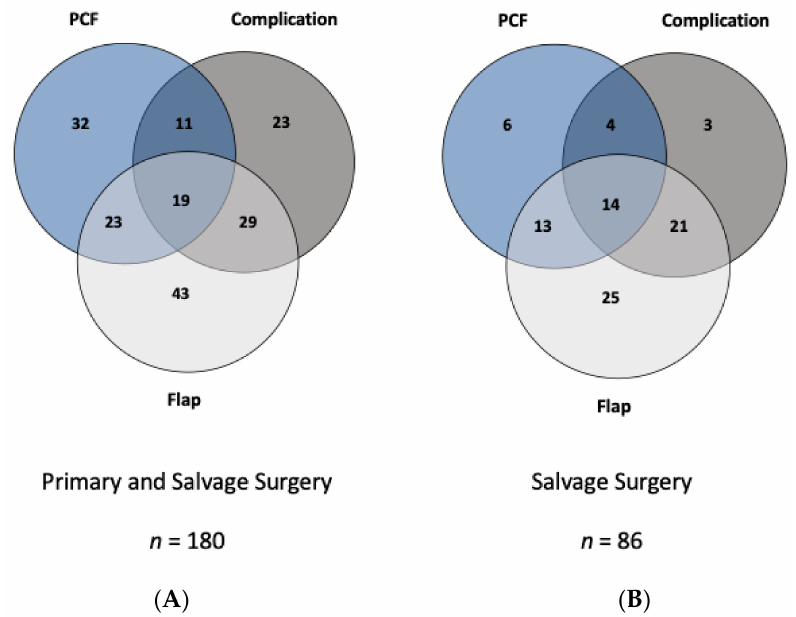
Figure 3. Association between complications, pharyngocutaneous fistula, and flap usage in primary and salvage surgeries. Occurrence of pharyngocutaneous fistula (PCF), short-term complications, and usage of flap during first surgery are illustrated in the Venn diagrams for the whole cohort ( A ) and those patients after salvage surgery ( B ). Using this type of illustration, the interconnections between flap use, PCF, and other complications are better intelligible. As exemplified for cohort A, 71 out of 114 patients who underwent flap reconstruction experienced postoperative complica- tion 16.1% ( n = 29), PCF formation 12.8% ( n = 23), or both 10.6% ( n = 19). Conversely, in group ( B ), 14 (16.3%) patients underwent flap reconstruction and experienced both PCF formation and postoperative